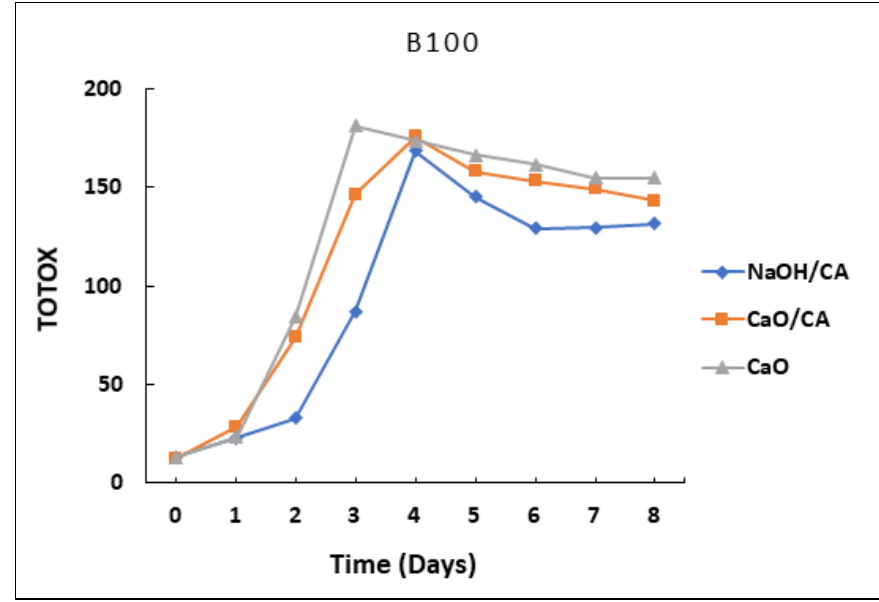
Figure 6. The TOTOX value for degraded biodiesel for increasing times based on PV and AnV.